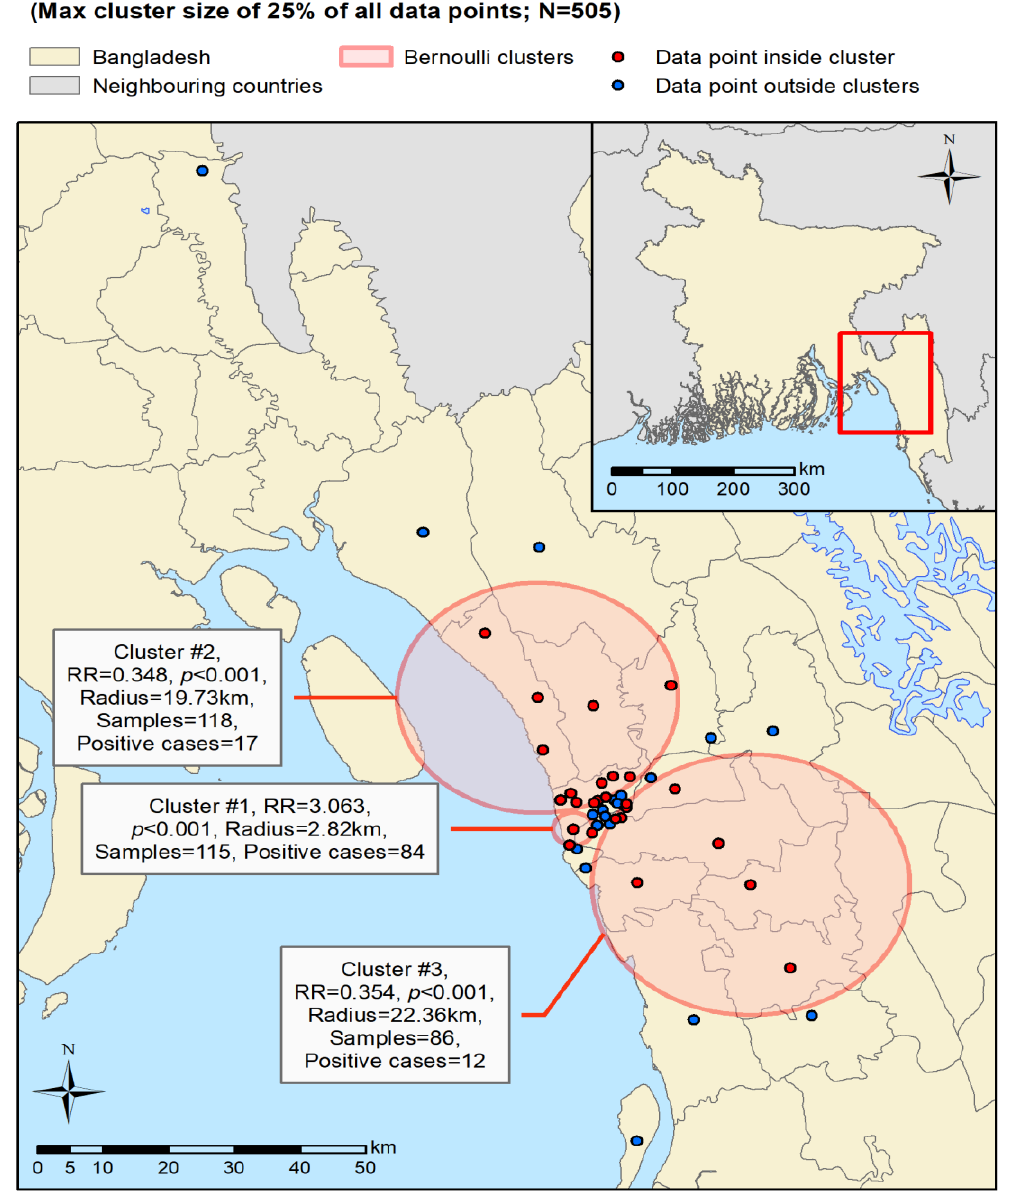
Figure 4. SaTScan clusters for HEV test results in Bangladesh, where RR represents relative risk and p represents p -value. p represents p